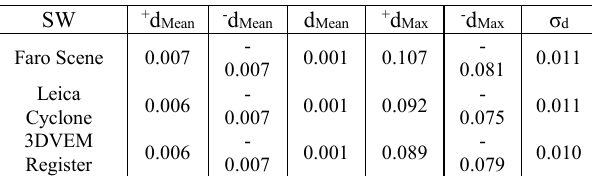
Table 1. Distance deviations between point clouds and meshes (in m) Table 2 reports on the differences achieved among meshes.